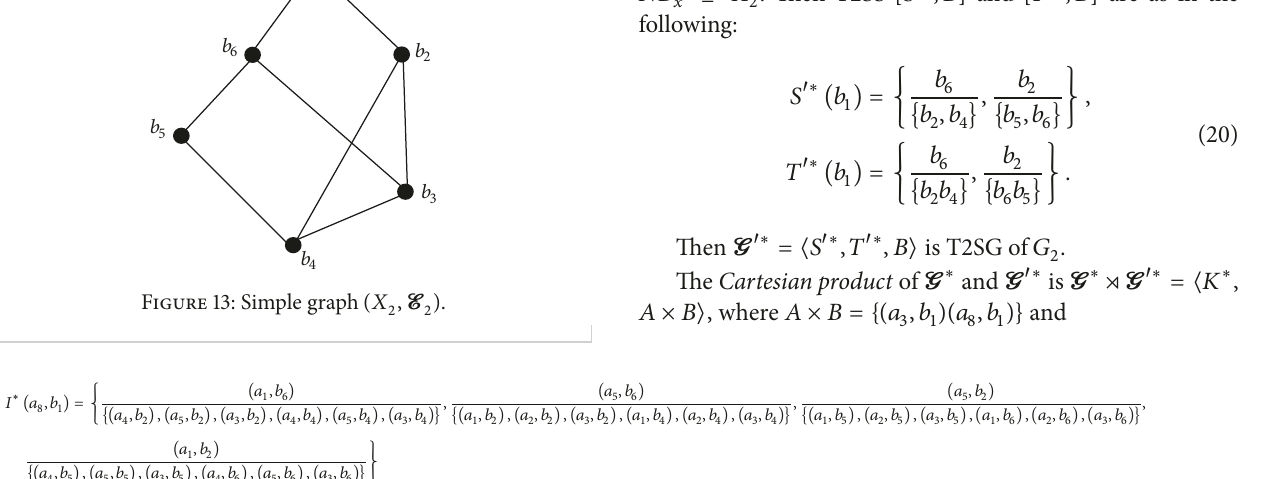
Figure 13: Simple graph (𝑋 2 , E 2 )